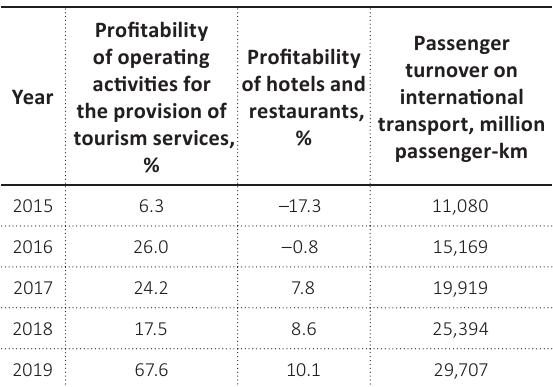
Table 3. Dynamics of efficiency indicators